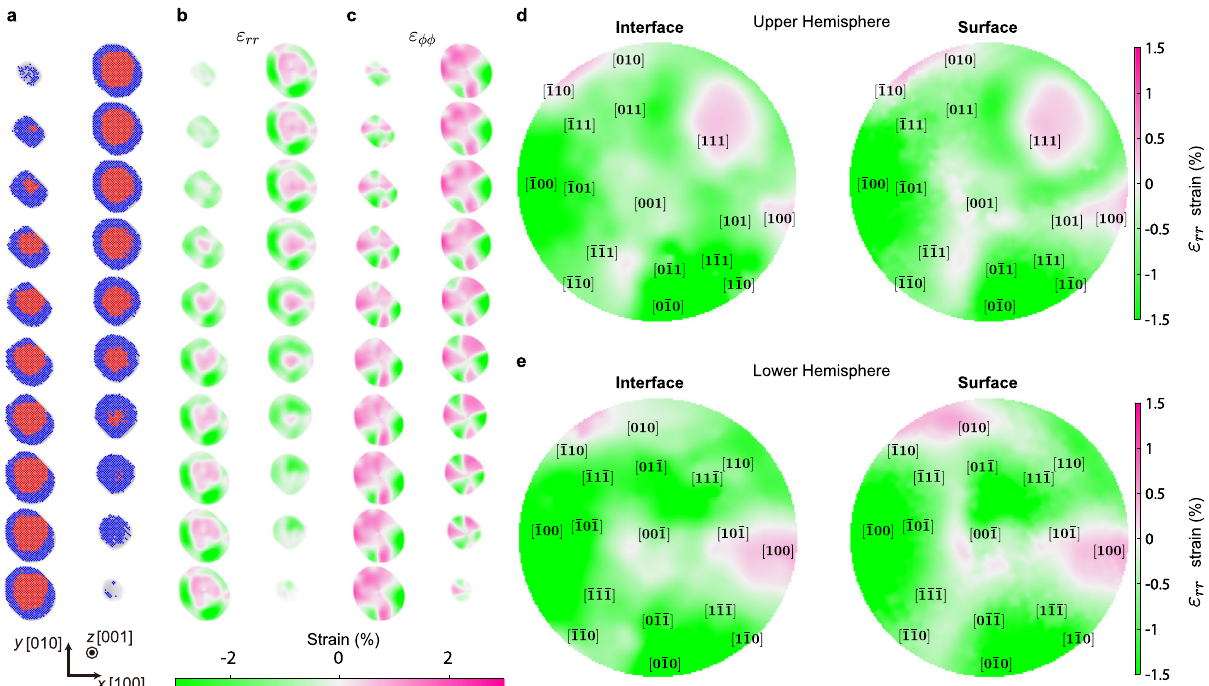
Fig. 4 | 3D strain maps and pole fi gures ofthe core-shell structure obtainedby an MS simulation. a The core-shell atomic structure resulting from the MS simu- lation(Methods),whichisdividedintoatomiclayersalongthe[001]direction.Note that only one layer per every two atomic layers is plotted. The red and blue dots represent the positions of Pd and Pt atoms assigned to the fcc lattice, respectively. b – c The calculated strain maps from the MS simulation result for the radial ( ε rr ) ( b ) and azimuthal ( ε ϕϕ ) ( c ) strains in the spherical coordinate system,